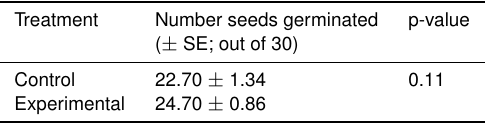
Table 2. Germination rates after four generations.